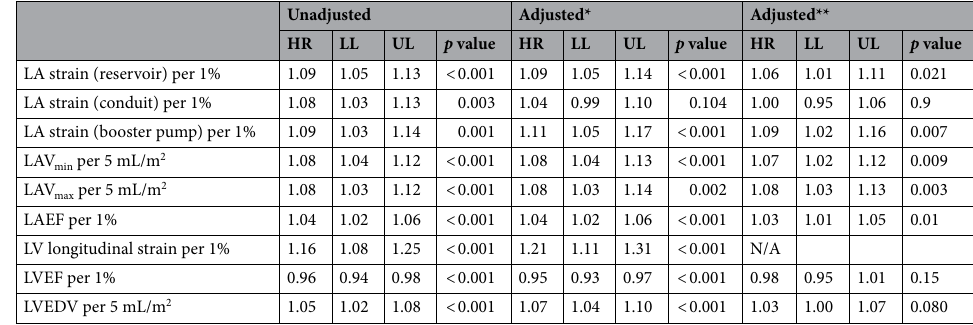
Table 4. The associations between LA features and increased hazards of clinical composite outcome. HR = hazard ratio; LL = lower limit; UL = upper limit; LAV max = left atrial maximum volume; LAV min = left atrial minimum volume; LAEF = left atrial emptying fraction; LV = Left ventricle. *Adjusted for age, gender, BSA (except in models with LAV max and LAV min ), diabetes, hypertension, and smoking status. **Additionally adjusted for left ventricular global longitudinal